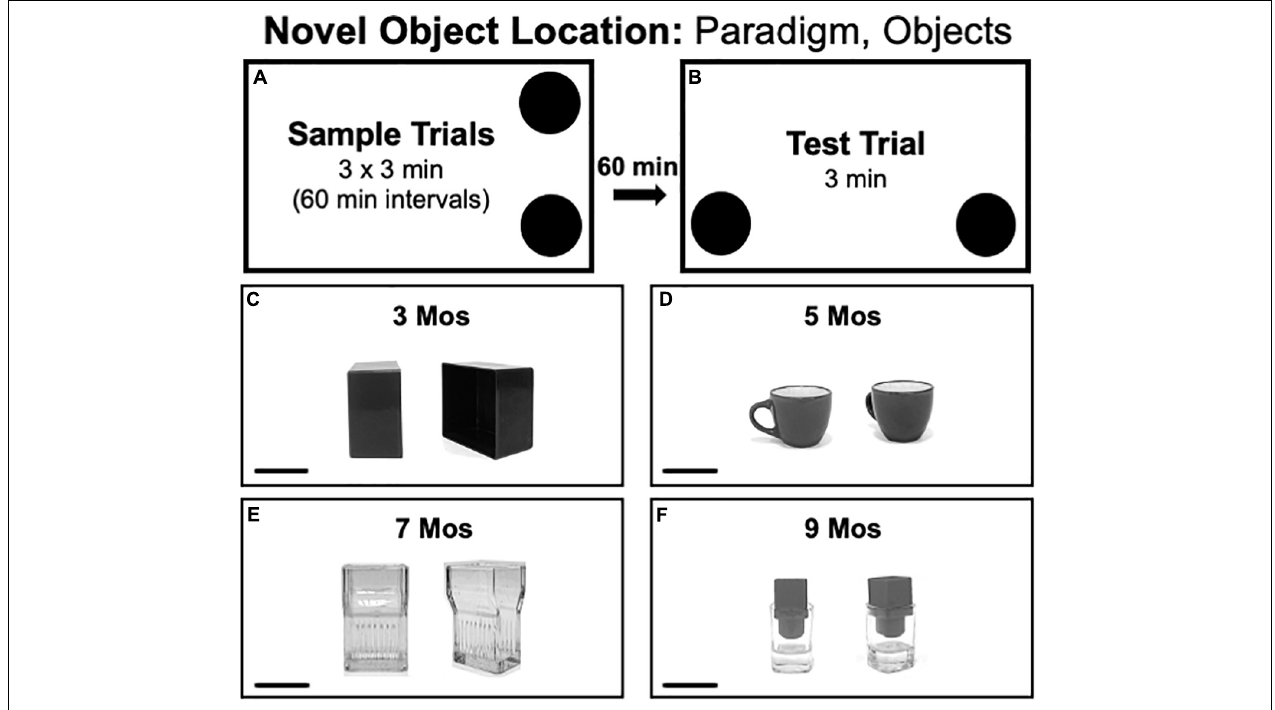
FIGURE 3 | (A,B) Schematic diagrams showing trial structure for the Novel Object Location paradigm. (C–F) Black and white photographs show the paired items that were used as sample objects for testing at each of the four ages evaluated [3, 5, 7, and 9 months (mos) of age]. The objects used in testing at 3 mos of age (C) were made of plastic. The objects used in testing at 5 mos of age (D) were made of ceramic. The objects used in testing at 7 mos of age (E) was made of glass micglass, and objects used in testing at 9 mos of age (F) were made of glass and plastic. Scale bars = 50